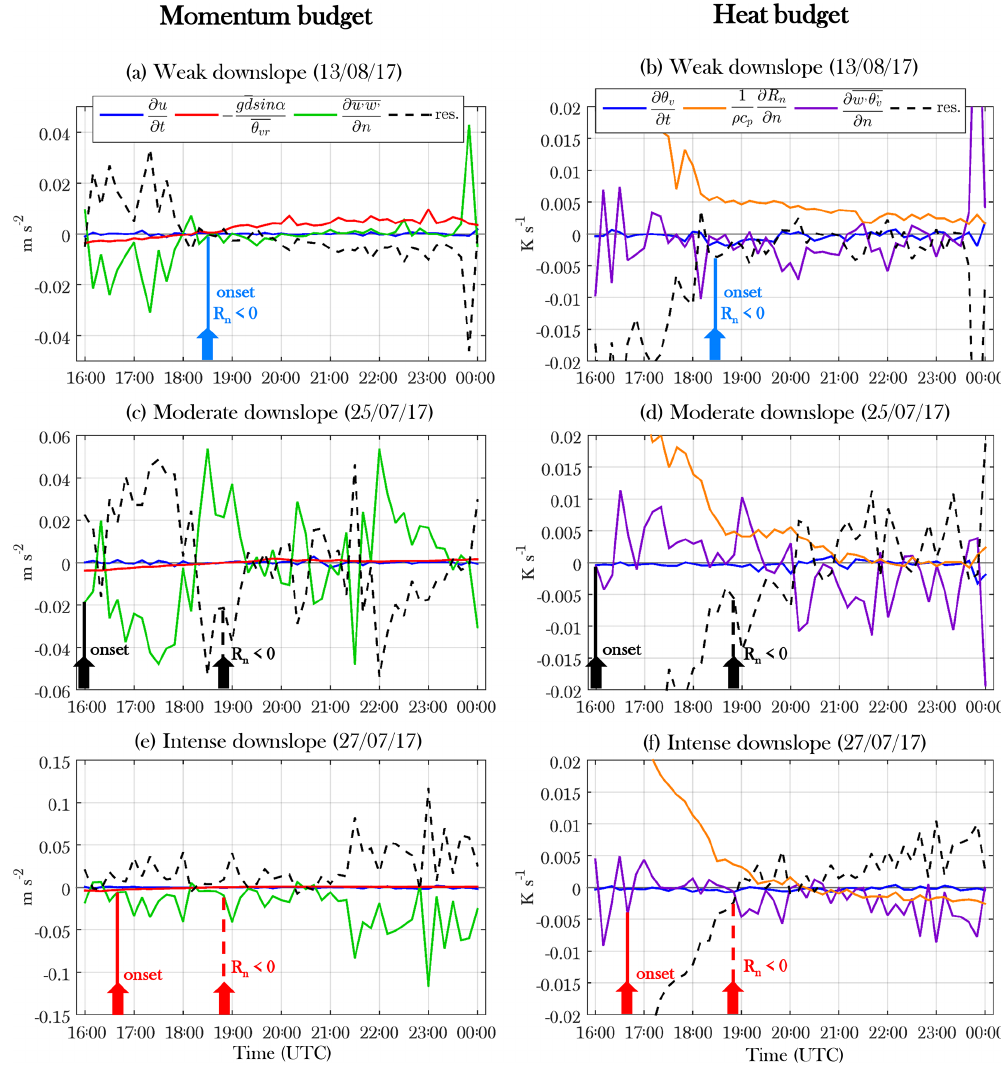
Figure 7. Time evolution of the different terms from the momentum (a, c, e) and heat budget (b, d, f) for the weak downslope (a, b) , moderate downslope (c, d) and intense downslope (e, f) events. The solid arrows point to the downslope onset time (with the vertical solid line) and the time at which R n turns negative (with the dashed vertical